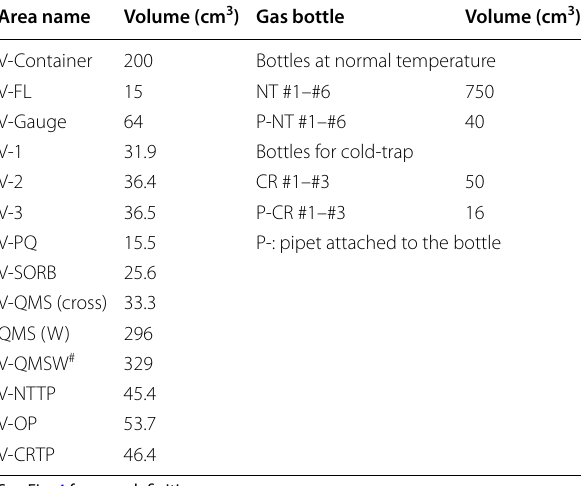
Table 1 Volumes of each gas-expanding area of the GAEA and gas bottles collecting Hayabusa2 container gases